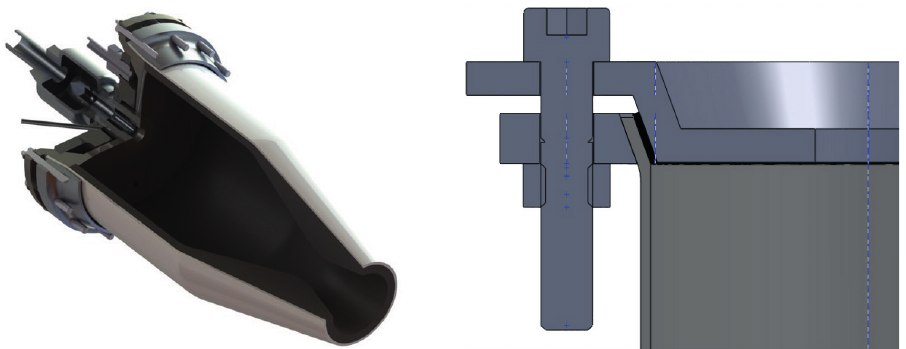
Figure 12. Revised connection of combustion chamber and injector head with a conical flange connection ( left ), which clamps the OCMC with a circumferential ring ( right ).